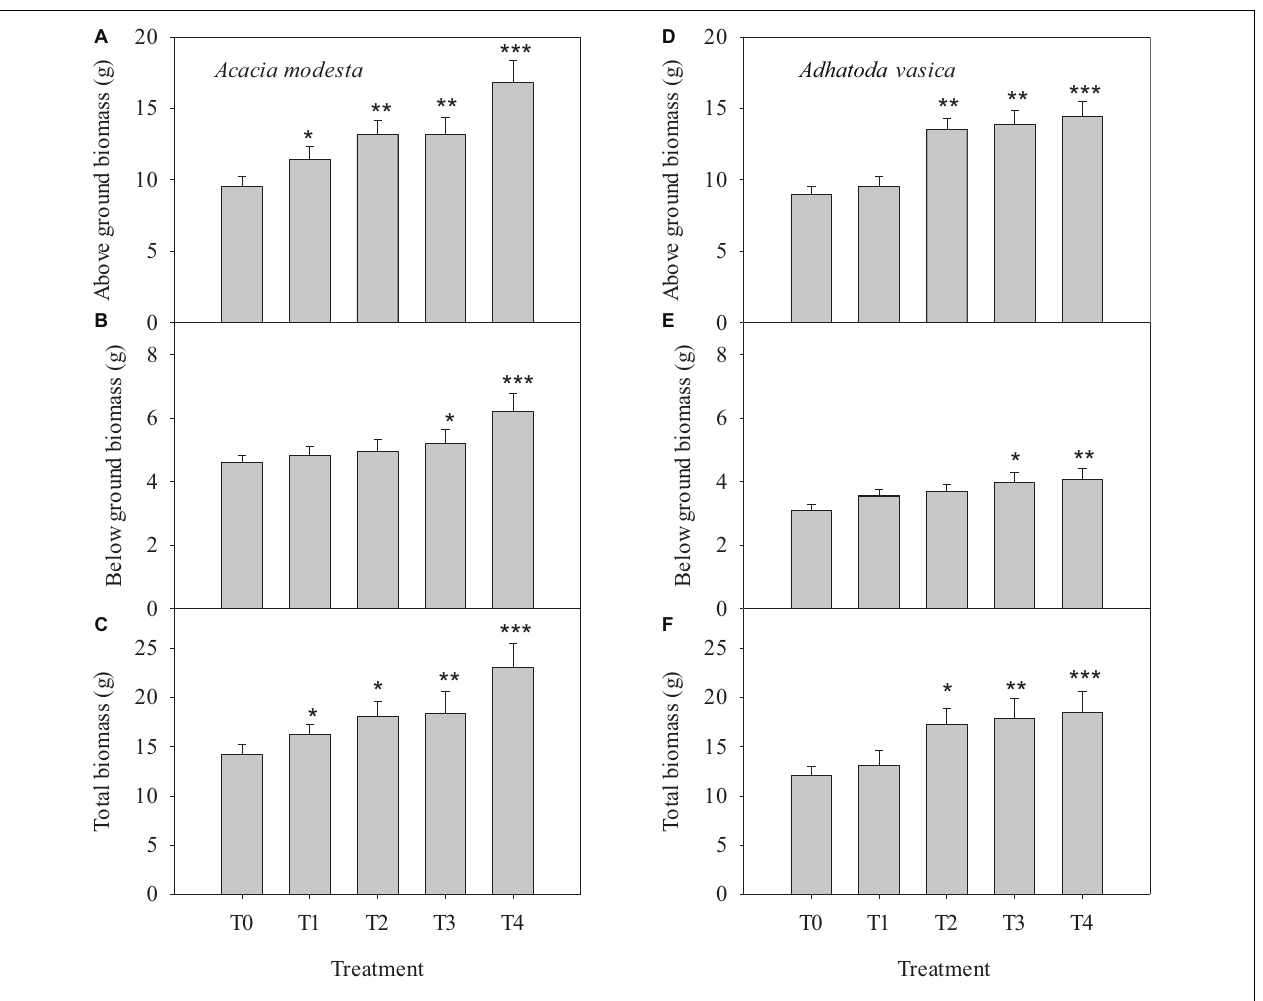
FIGURE 4 | Effect of quarry waste on above ground biomass, below ground biomass, and total biomass in Acacia modesta (A–C) and Adhatoda vasica (D–F) . The asterisk indicate the significant difference of treatment means with the control (T0): * P < 0.05, ** P < 0.01, and *** P <